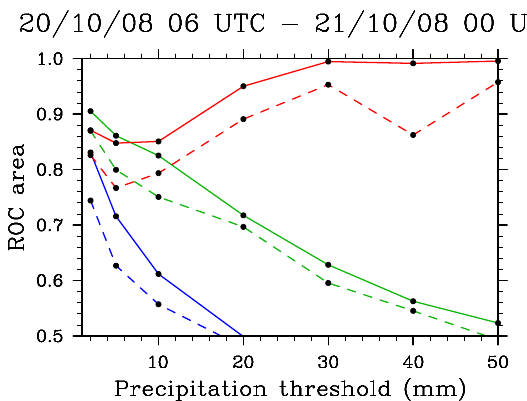
Fig. 17. Area under the ROC curve as a function of precipitation threshold obtained for the 18h accumulated precipitation. Comparison of the E3 (blue), E6 (green) and E7 (red) ensembles. The dotted lines correspond to the deterministic forecasts. added value (as estimated from the departure of the ensem- ble curve to its corresponding deterministic forecast curve) seems to be superior when the resolution is